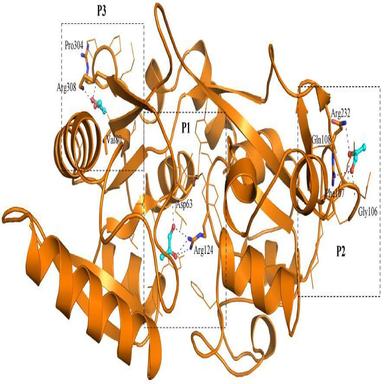
Molecular docking. Cartoon representation of hTF in complex with MG. Polar interactions sharing residues are showing in stick element colour, and other interacting residues are showing in line model. P1-P3 are predicted binding pockets where MG is binding with different poses and interactions.